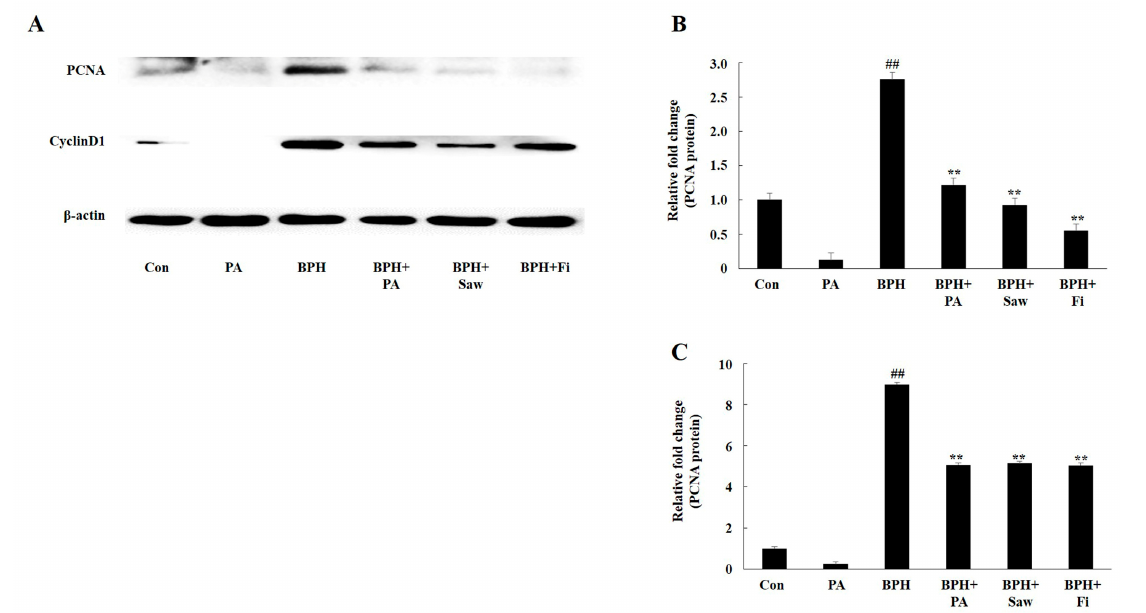
Figure 6. Effect of PA administration on the expression of prostate cell proliferation-related proteins in rats with TP-induced BPH. Representative Western blot showing the bands of proliferating cell nuclear antigen (PCNA) and cyclin D1 ( A ). PCNA expression in the samples from the rats in each group ( B ). Cyclin D1 expression in the samples from the rats in each group ( C ). Abbreviations: Con, corn oil, s.c. and D.W.-treated rats; PA, corn oil, s.c. and PA 100 mg/kg-treated rats; BPH, TP, s.c. and D.W.-treated castrated rats; BPH+PA, TP, s.c. and PA 100 mg/kg-treated castrated rats; BPH+Saw, TP, s.c. and saw palmetto 100 mg/kg-treated castrated rats; BPH+Fi, TP, s.c. and Fi 1 mg/kg-treated castrated rats. The data are expressed as the means ± SEMs. ## p < 0.01, compared with the Con group; ** p < 0.01, compared with the BPH group.